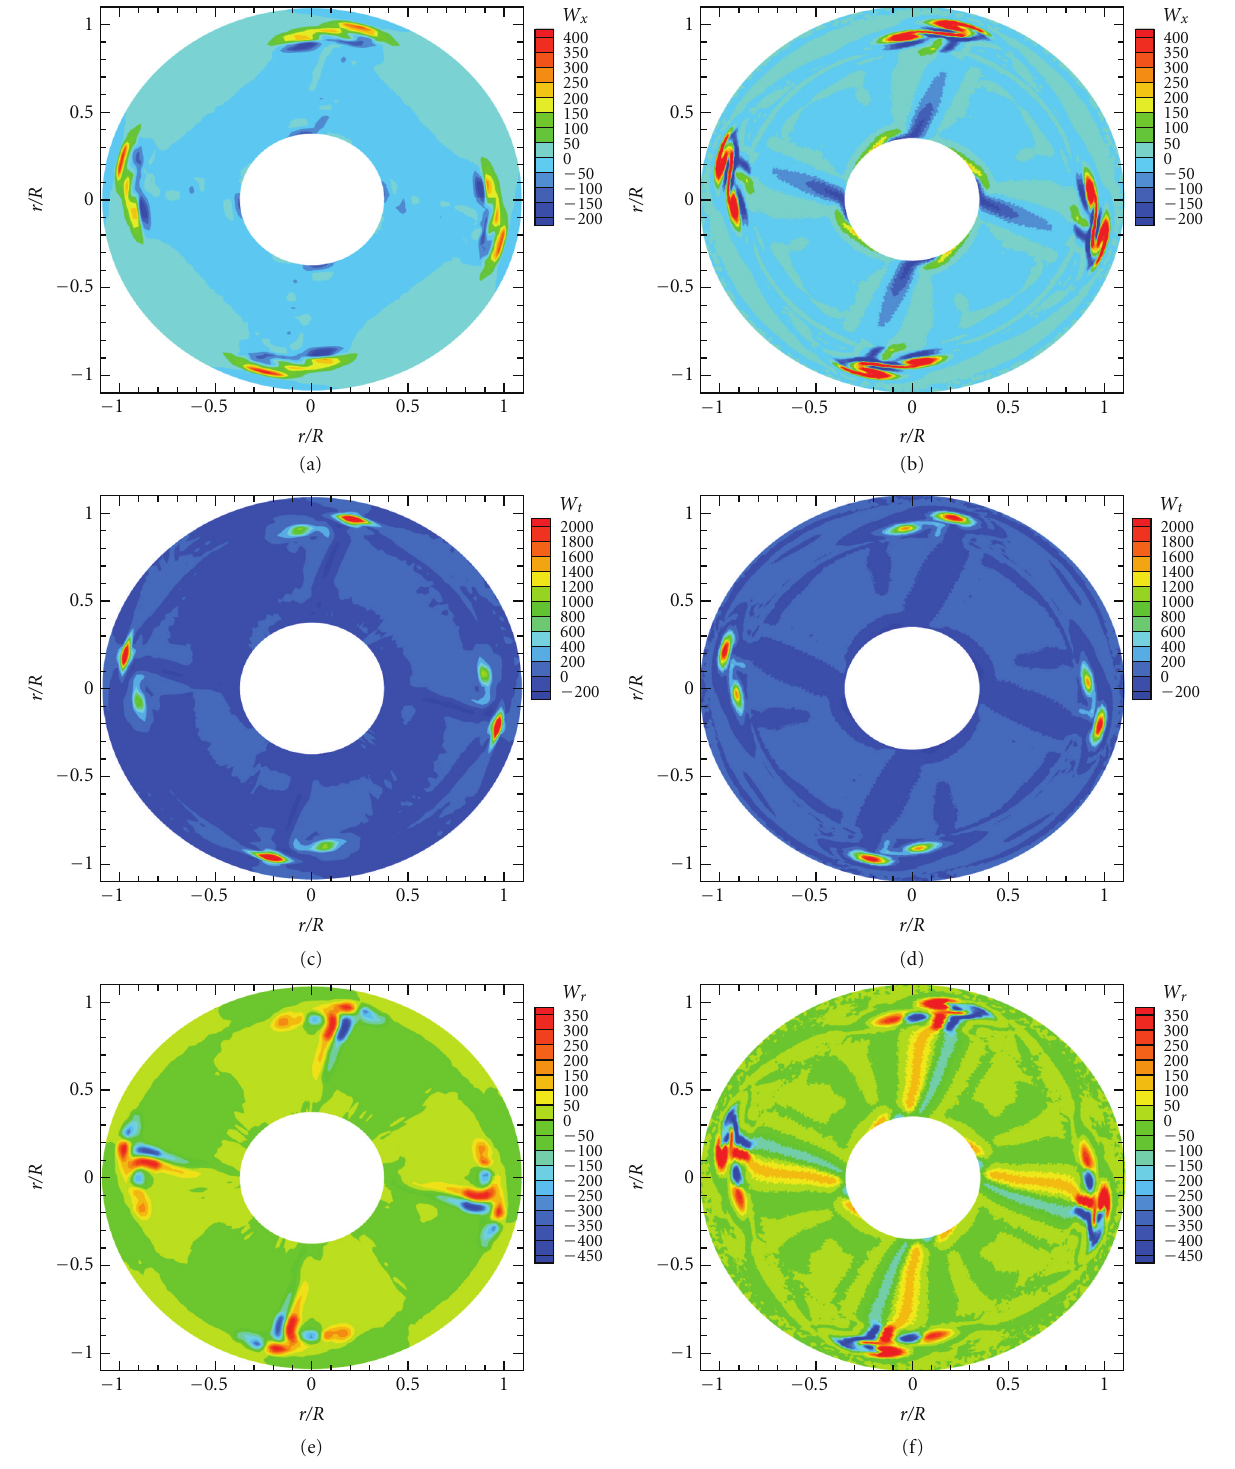
Figure 17: Axial, tangential, and radial vorticity distributions at x/R = 0.5000 aft the propeller plane. ((a), (c), and (e)) Experimental LDV measurements. ((b), (d), and (f)) RANSE computations on the finer